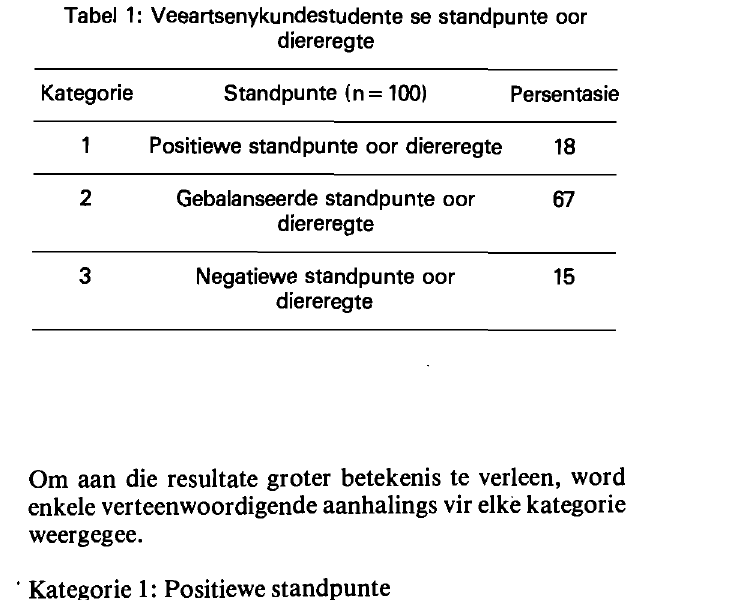
Tabel 1: Veeartsenykundestudente se standpunte oor